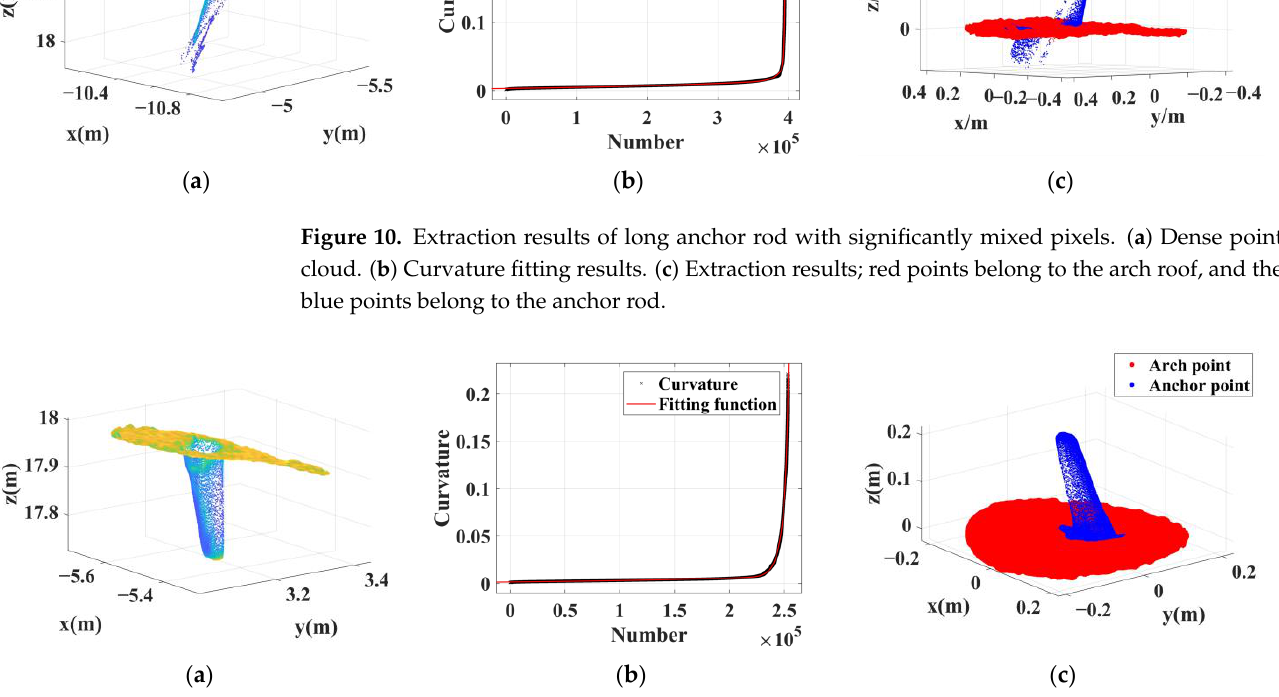
Figure 11. Extraction results of short anchor rod with a few mixed pixels. ( a ) Dense point cloud. ( b ) Curvature fitting results. ( c ) Extraction results; red points belong to the arch roof, and the blue points belong to the anchor rod.